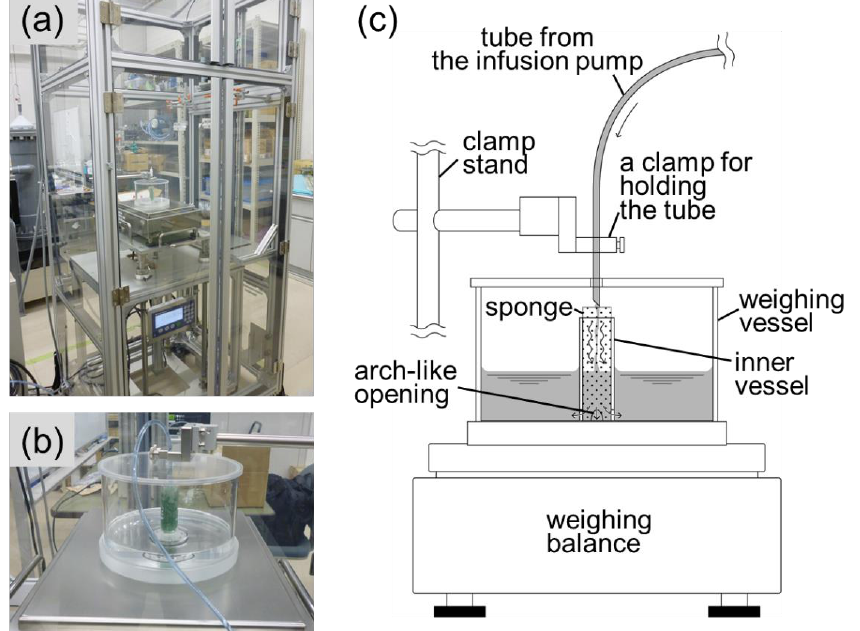
Figure 9. Gravimetric test bench for flow rate measurement. ( a ) A weighing balance sits on a liftable stage inside a wind shield enclosure. ( b ) A specially designed weighing vessel sits on a weighing plate. ( c ) Features of the weighing vessel.